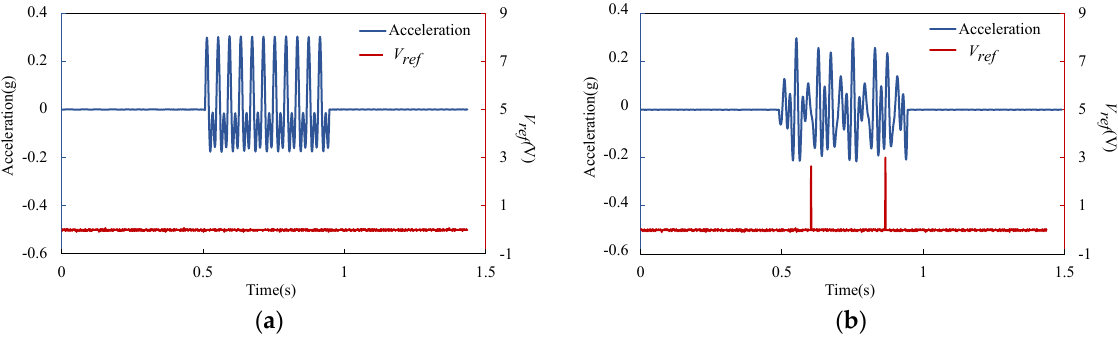
Figure 15. Experimental result of the voltage across the reference resistor and the excitation accelera- tion in time domain: ( a ) 25 Hz and 50 Hz excitation; ( b ) 25 Hz, 40 Hz and 50 Hz